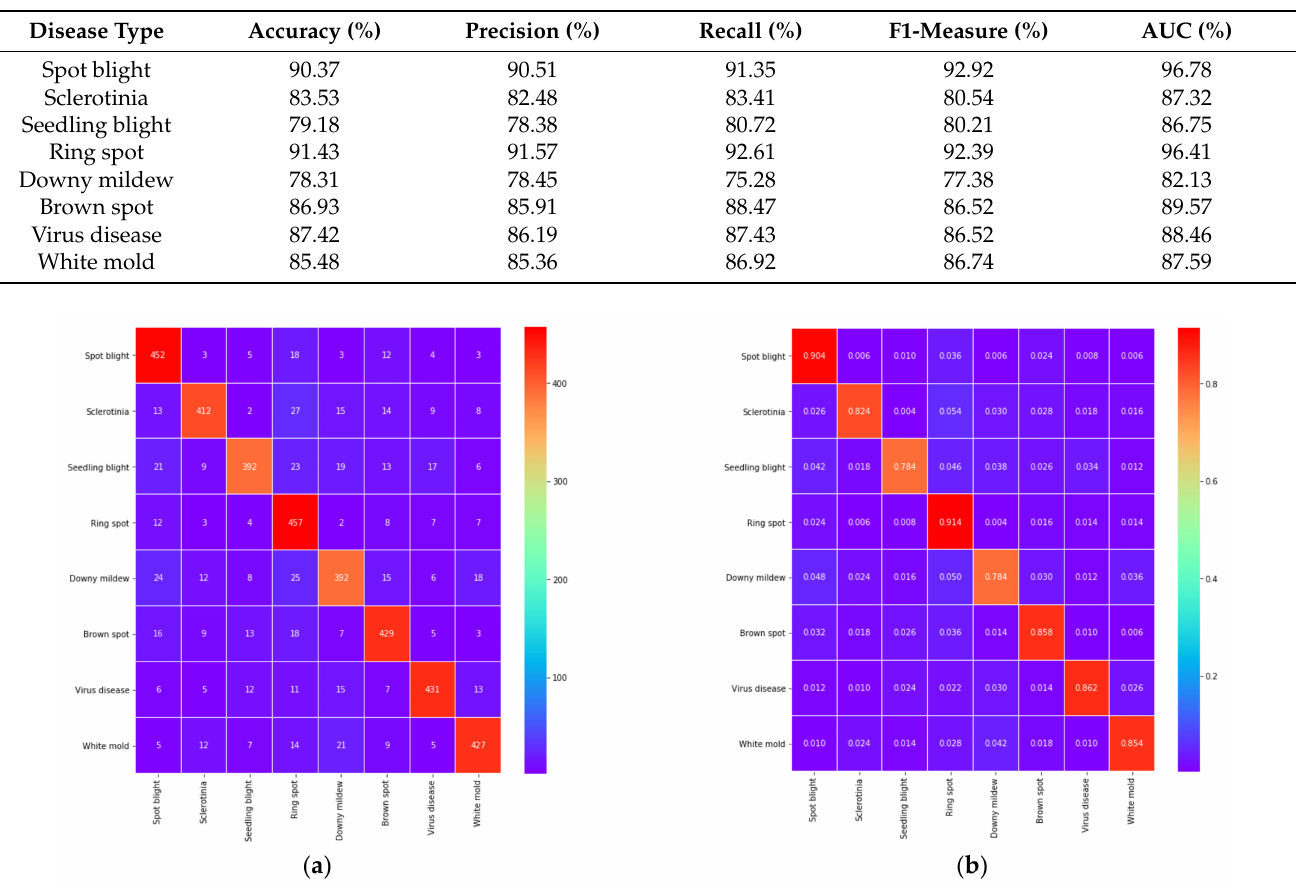
Figure 21. Buckwheat disease classification; ( a ) confusion matrix, ( b ) normalized confusion